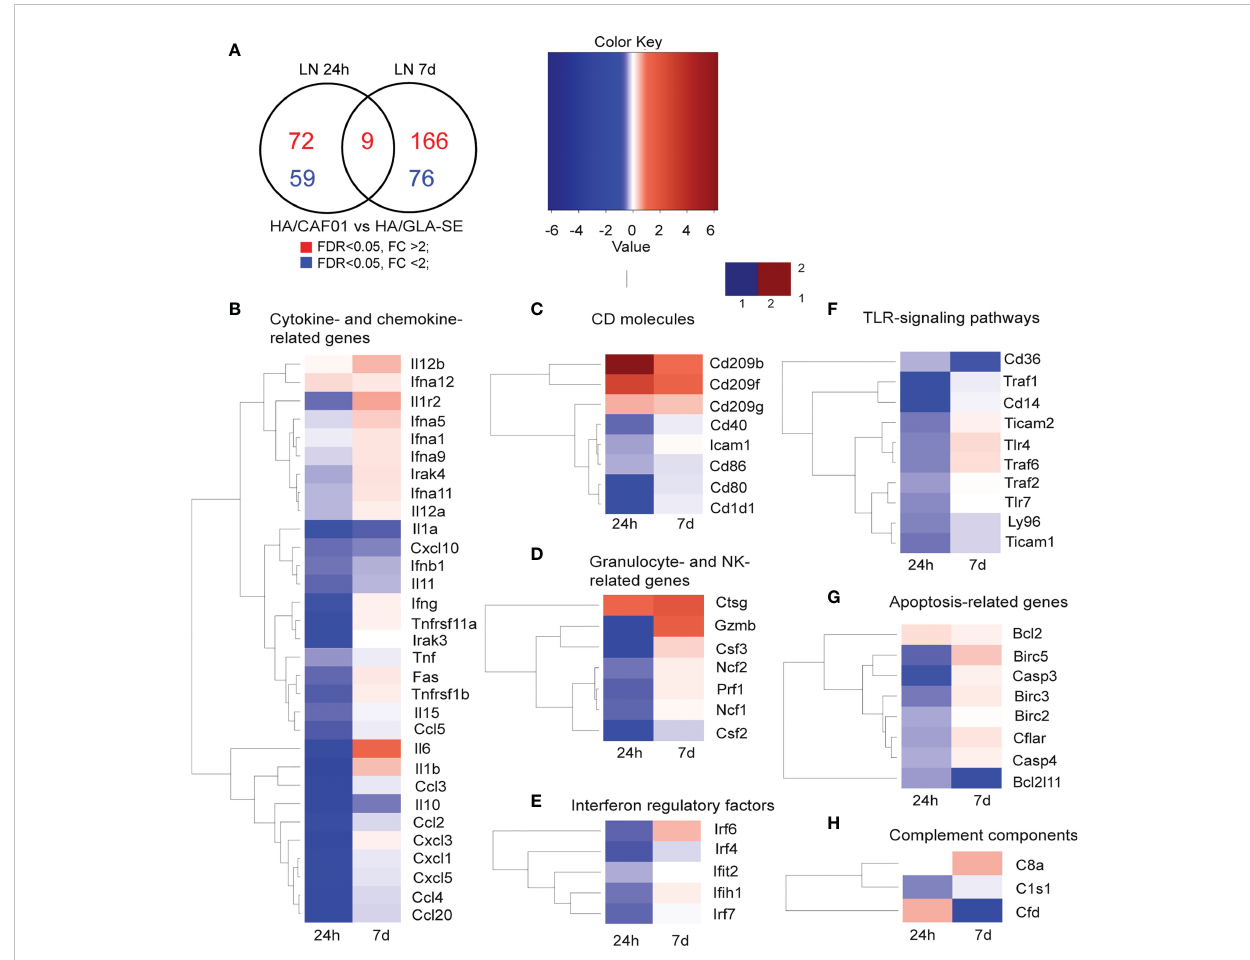
FIGURE 3 Co-expression analysis in dLNs revealed shared and unique features of CAF01 and GLA-SE adjuvan ts. Groups of neonatal CB6F1 mice were immunized s.c. with HA alone or formulated with CAF01 or GLA-SE. Transcriptomic pro fi les resulting from the comparison HA/CAF01 versus HA/ GLA-SE are shown. (A) Venn diagram depicts the numbers of genes that were signi fi cantly up-regulated (red) or down-regulated (blue) in the HA/ CAF01 group compared with the HA/GLA-SE group in inguinal draining LNs at 24 h and 7 days post immunization. (B – H) Heat maps show the expression pro fi les of selected genes associated with (B) cytokine and chemokine activity, (C) encoding for CD molecules, (D) granulocyte- associated genes, (E) interferon regulatory factors, (F) TLR signaling genes, (G) apoptosis-related genes and (H) complement